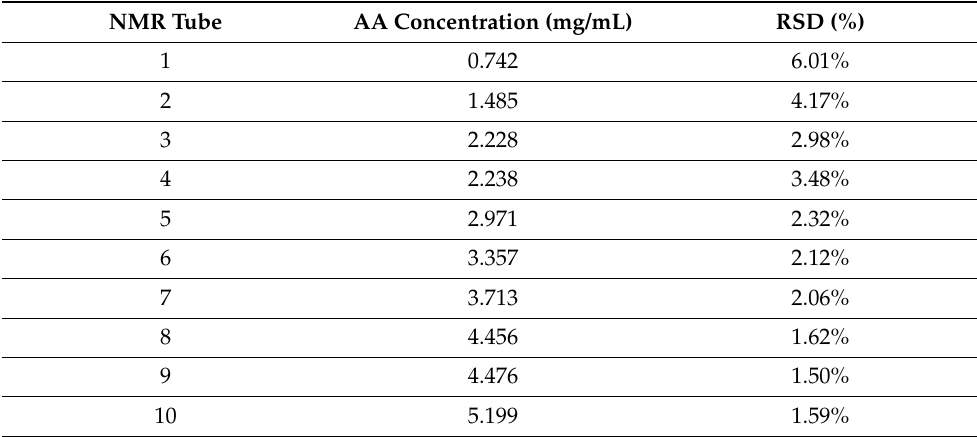
Table 6. Evaluation of AA stability over time.